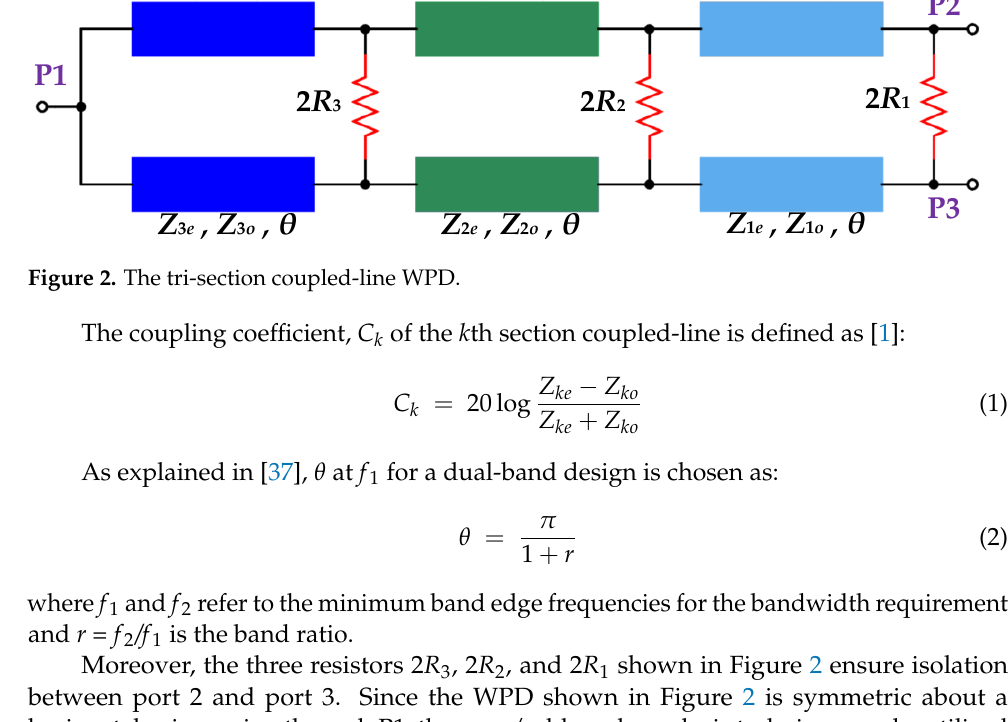
Figure 3. ( a ) The even-mode equivalent circuit, ( b ). The odd-mode equivalent circuit.